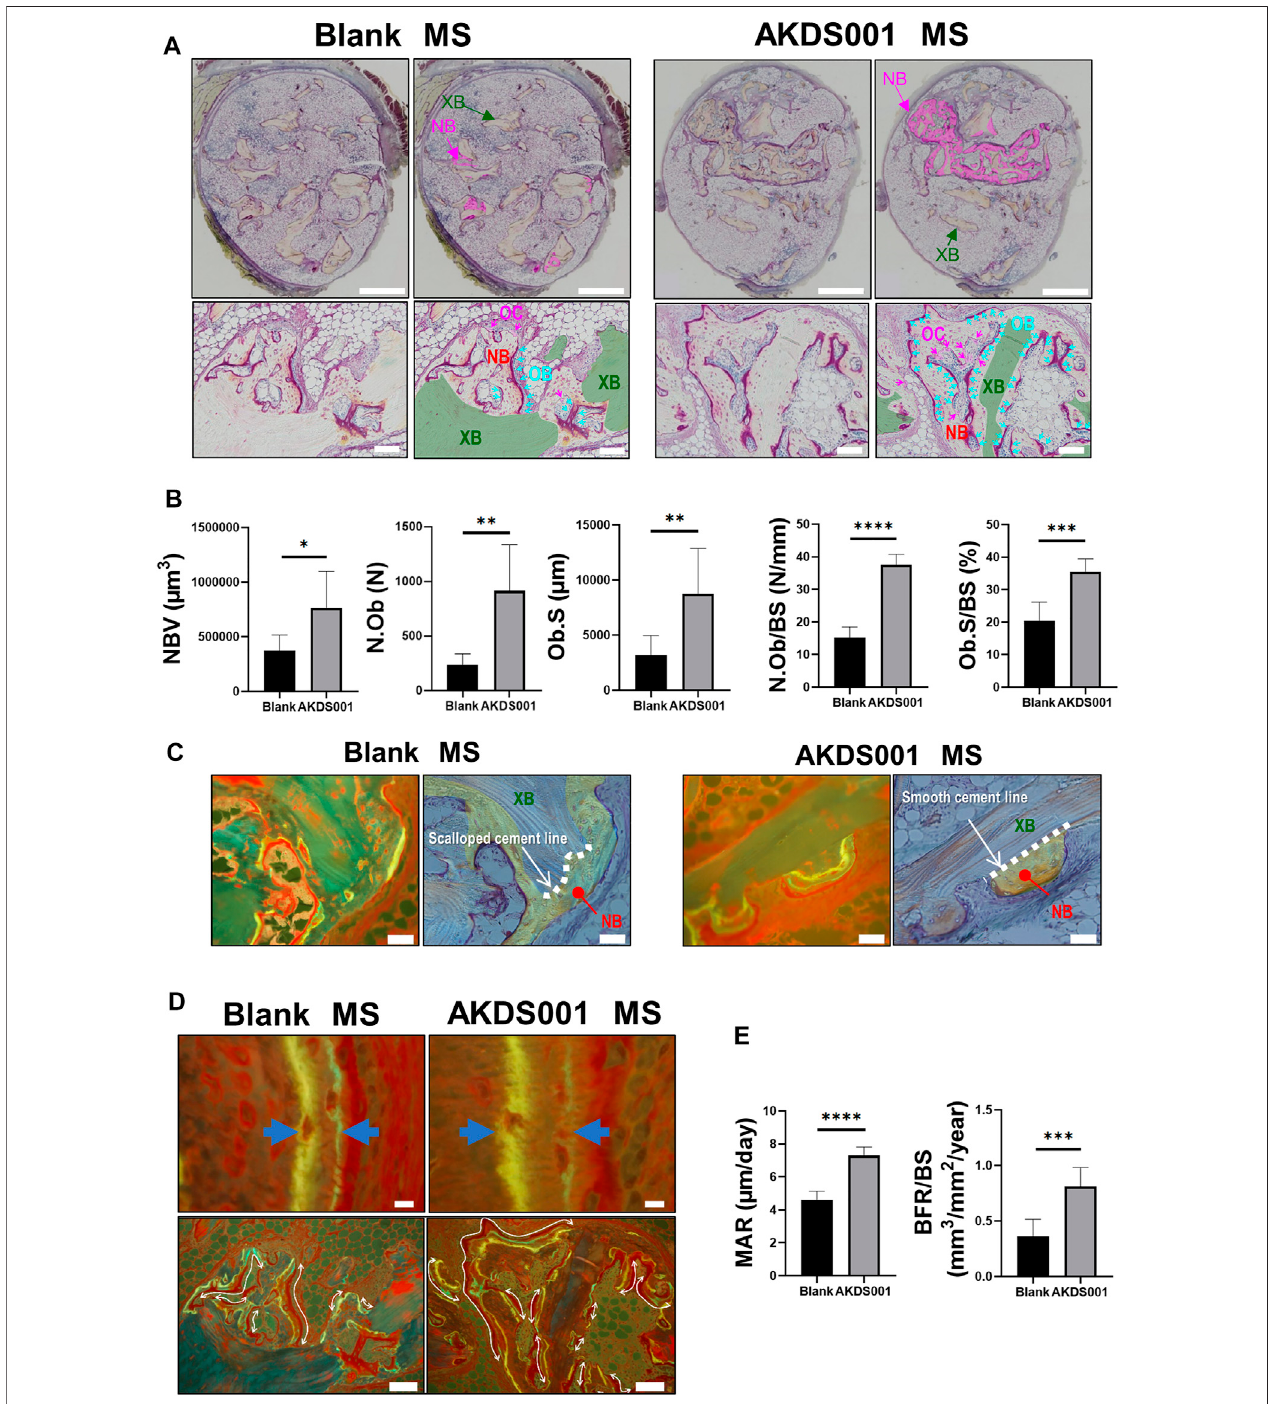
FIGURE 4 | Histomorphometric analysis of Blank MS versus AKDS001 MS (1.0 mg/ml) in newly formed bone. (A) Representative images of Villanueva bone stainingof extracted samples. Scale bars, 1 mm (upper) and 100 μ m (lower). NB, new bone; XB, xenografted bone; OB, osteoblast; OC osteoclast. In the upper image, the NB area is painted with pink. In the lower image, the XB area is painted with green; Ob is colored blue (blue arrow); OC is colored pink (pink arrow). (B) New bone volume (NBV), number of osteoblasts (N.Ob), osteoblast surface (Ob.S), N.Ob/bone surface (BS), and Ob.S/BS on new bone. (C) Representative images of new boneformation.Villanuevabonestaining(upper)and fl uorescentimageofthesamearea(lower).Scalebars,50 μ m.Intheupperimage,non-NBareasare fi lledwithblue. The boundary between the grafted bone and the new bone is traced by the dotted line. (D) Representative fl uorescent images of new bone. Scale bars, 10 μ m (upper) and100 μ m(lower).Thewidthofthedoublestainingareaisindicatedbyarrows(upper)andthedoublestainingareaisindicatedbycurves(lower). (E) Mineralapposition rate (MAR) and bone formation rate (BFR)/BS on new bone. * p < 0.05, ** p < 0.01, *** p < 0.001, **** p < 0.0001 by two-tailed Student ’ s t -test (unpaired).